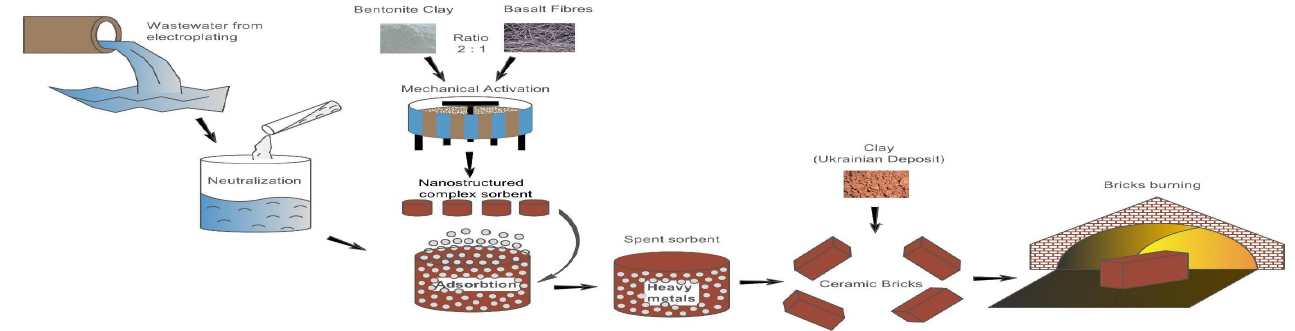
Figure 1. The proposed scheme for the use of spent sorbent after wastewater treatment from heavy metal ions in the production of ceramic bricks.